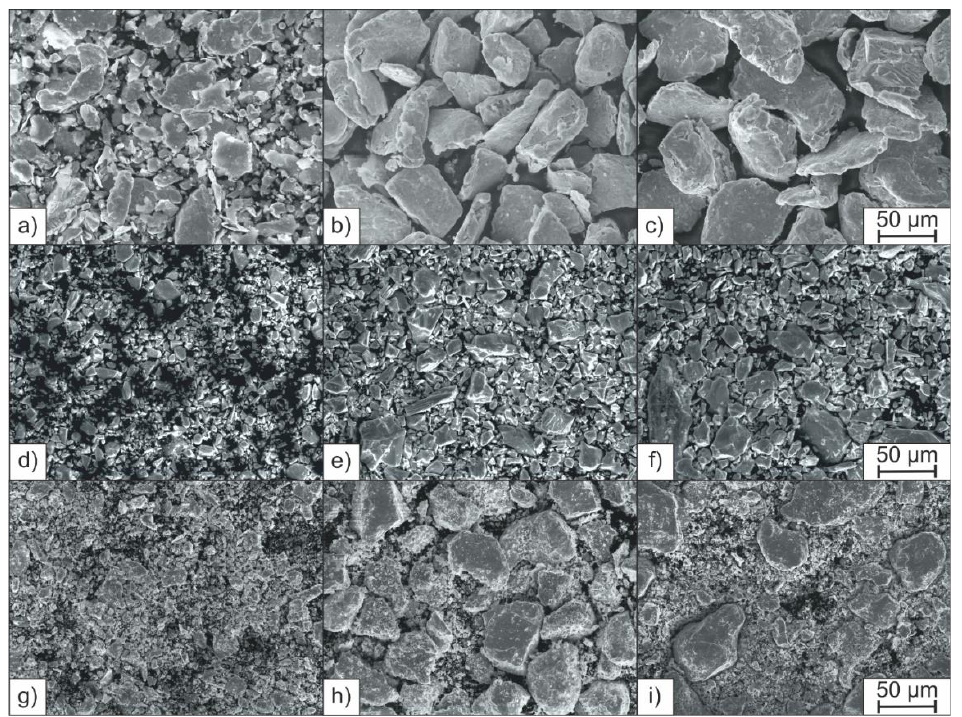
Figure 2. SEM images of the sieved fractions: ( a ) FeCrC < 28 µm, ( b ) FeCrC 28 – 45 µm, ( c ) FeCrC 45 – 63 µm, ( d ) Mn < 28 µm, ( e ) Mn 28 – 45 µm, ( f ) Mn 45 – 63 µm, ( g ) FeW < 28 µm, ( h ) FeW 28 – 45 µm, and ( i ) FeW 45 – 63 µm.